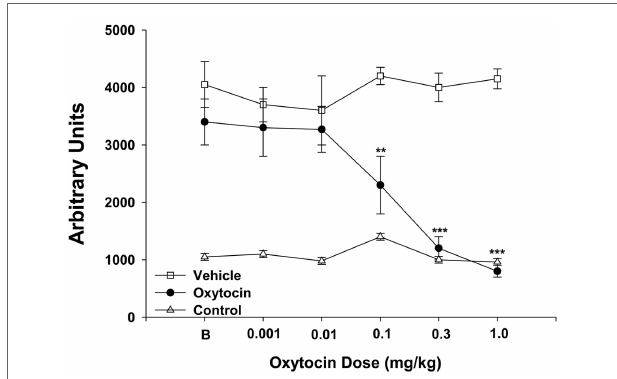
FiguRe 4 | Oxt dose-dependently decreases locomotor activity in self-administering methamphetamine rats . Oxt ( n = 5) was administered IP in ascending doses (0.001, 0.01, 0.1, 03, 1 mg/kg) over five consecutive days and equivalent amounts of vehicle ( n = 5) were administered. Only the animals treated with Oxt or vehicle self-administered methamphetamine, and the control ( n = 8) was used to determine baseline levels of locomotor activity. B = baseline day before oxytocin testing began. ** p < 0.01 and *** p < 0.001. There was no difference between rats treated with Oxt compared to the control group at 0.3 and 1 mg/kg Oxt dose. All other comparisons between Oxt treatment and the control group and the vehicle treatment and control groups were significant. Data are shown as mean ± SEM. Adapted and reprinted with permission from Elsevier: Carson et al.